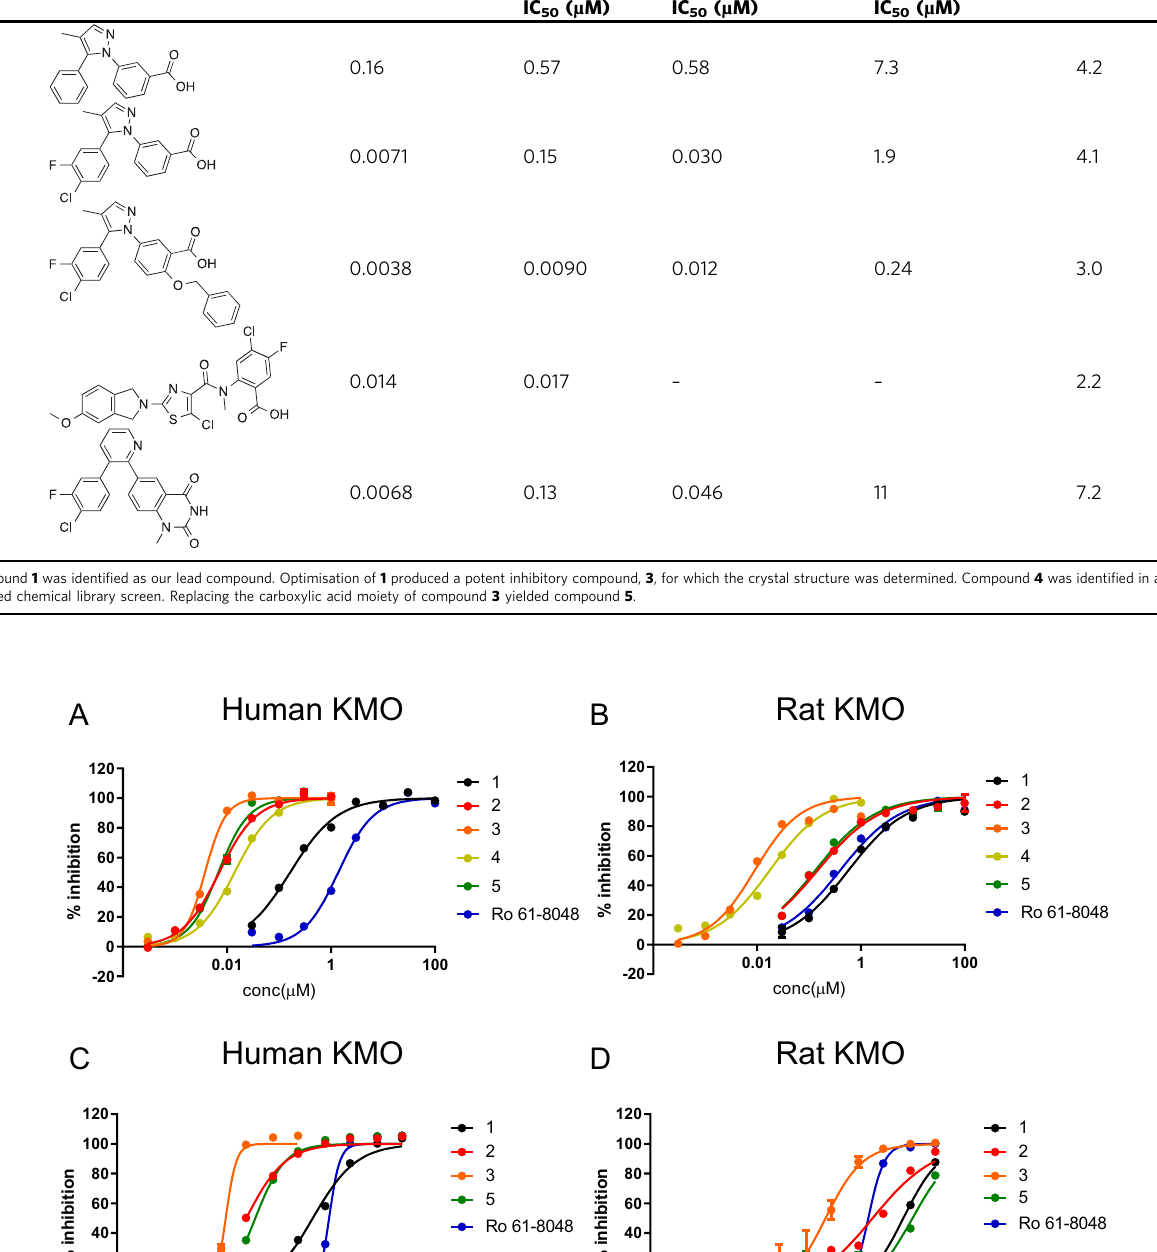
Table 1 Chemical structure and structure activity relationship of KMO-inhibiting compounds. No.